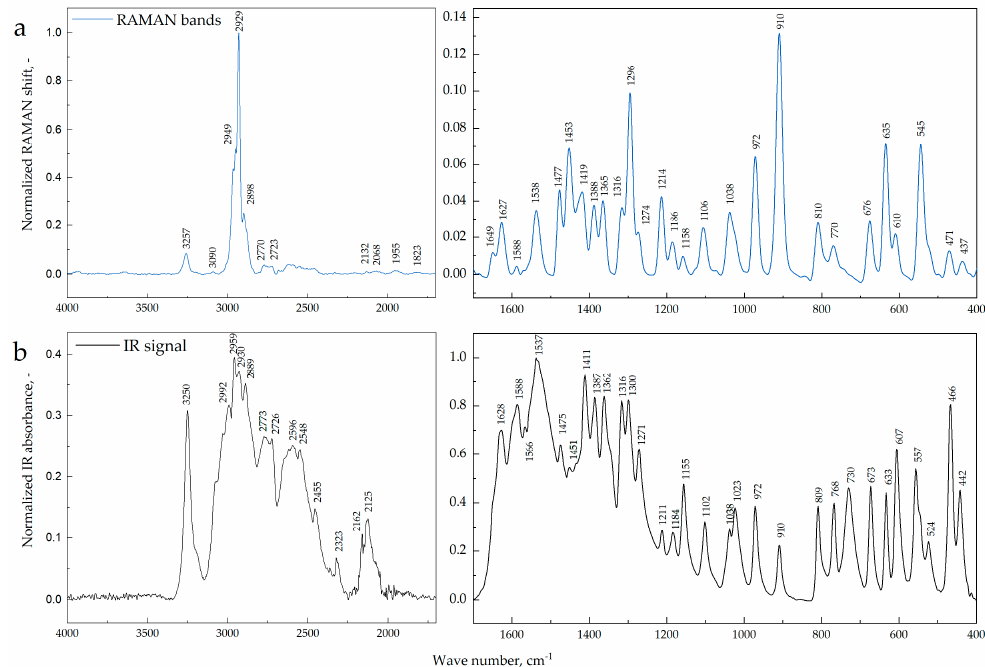
Figure 5. Raman ( a ) and IR spectra ( b ) of crystalline N γ -acetyl-L-2,4-diaminobutyric acid, obtained from cooling crystallization in H 2 O. The signal was normalized to the most pronounced peak, namely at 2929 cm − 1 and 1537 cm − 1 for Raman and IR spectroscopy, respectively. For the detailed assignment of the bands, see Table S9.